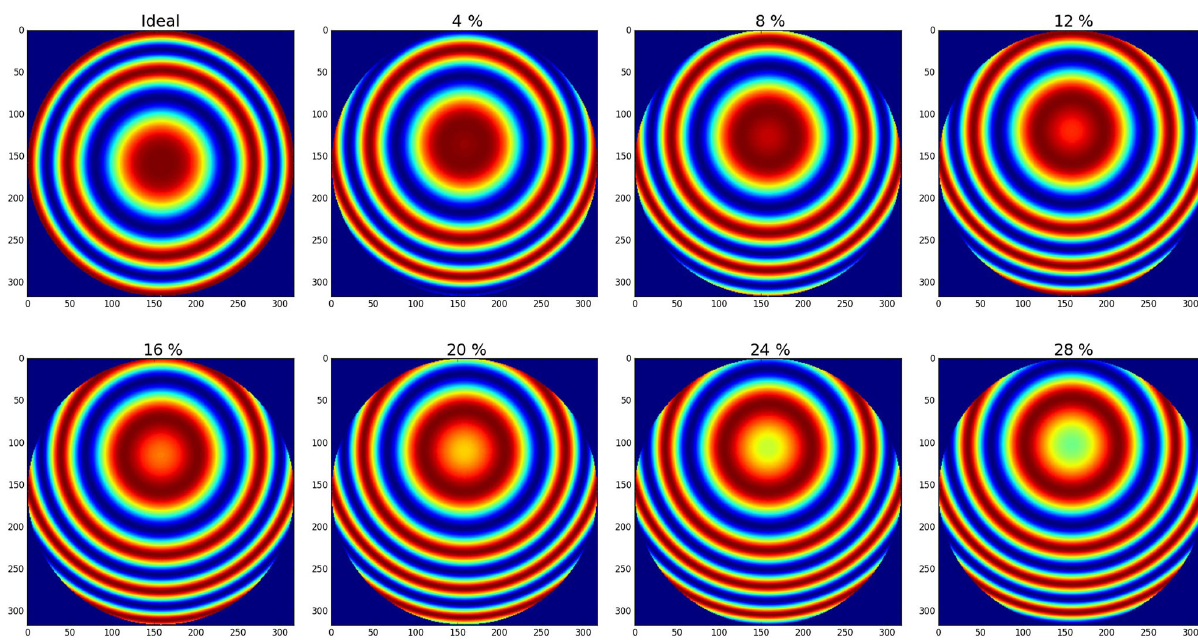
Figure 11. The Haidinger fringes at maximum OPD (the maximum misalignment position) for Fig. 10.